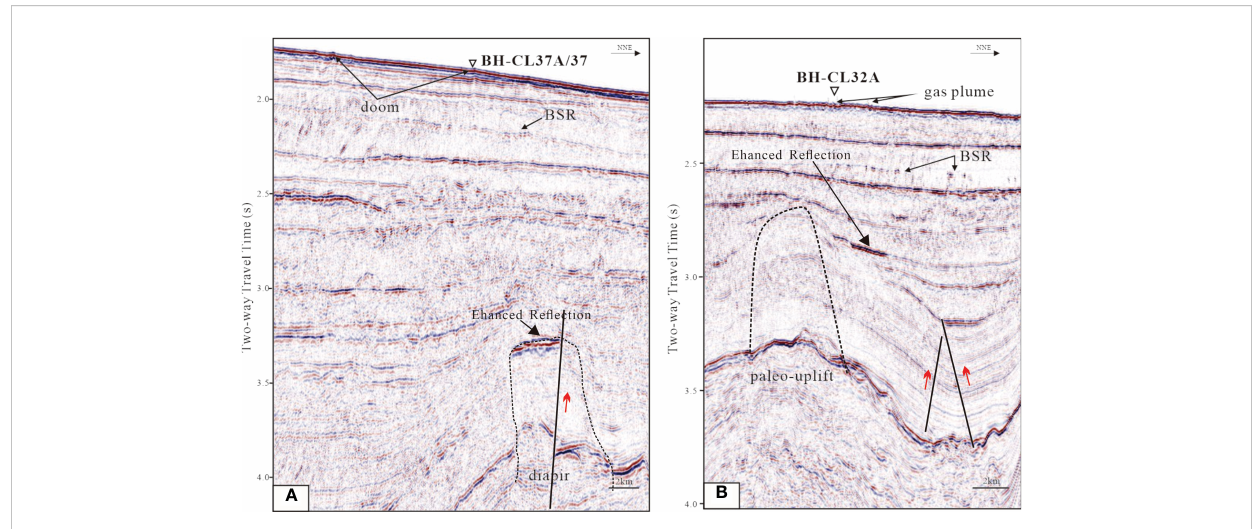
FIGURE 2 Seismic pro fi les of sampling sites in this study. (A) Seismic pro fi le of BH-CL37, weak continuity of BSR, fault, enhanced re fl ection and sea fl oor dome; (B) Seismic pro fi le of BH-CL32A, discontinuous BSR, fault, enhanced re fl ection and gas leakage on the sea fl